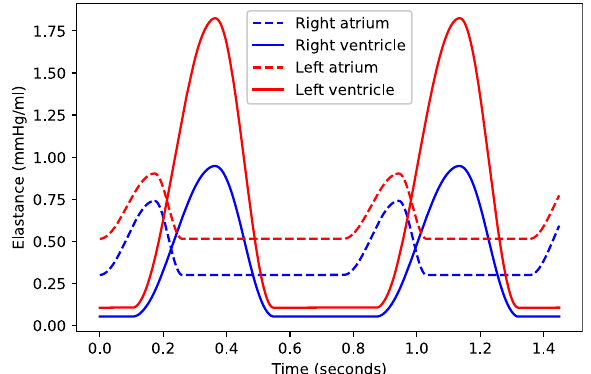
Fig. 4 Time-varying heart elastances. Red lines indicate the left heart, and blue lines the right heart. Dashed lines indicate the atria, and solid lines the ventricles.